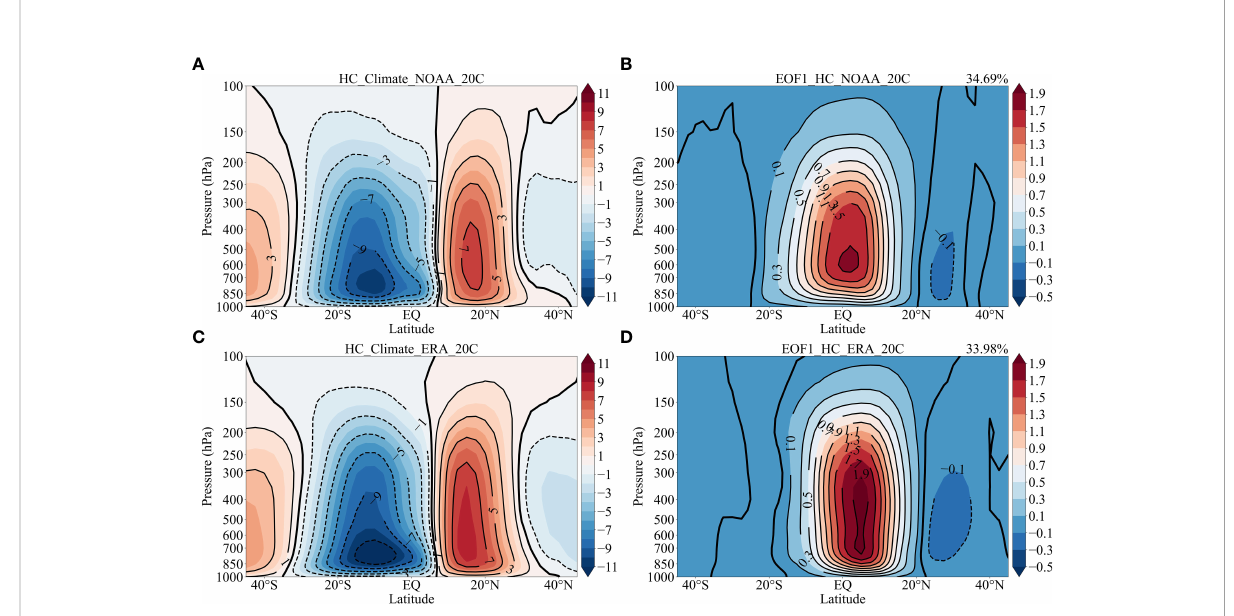
FIGURE 2 The climatological mean MSF from 1948 to1978 based on the (A) NOAA-20C and (C) ERA-20C. The contour interval is 2× 10 10 kg s -1 . (B, D) as in (A, C) but for the principal mode of the HC. Positive (negative) contours are displayed as solid (dotted) lines with an interval of 0.2×10 10 kg s − 1